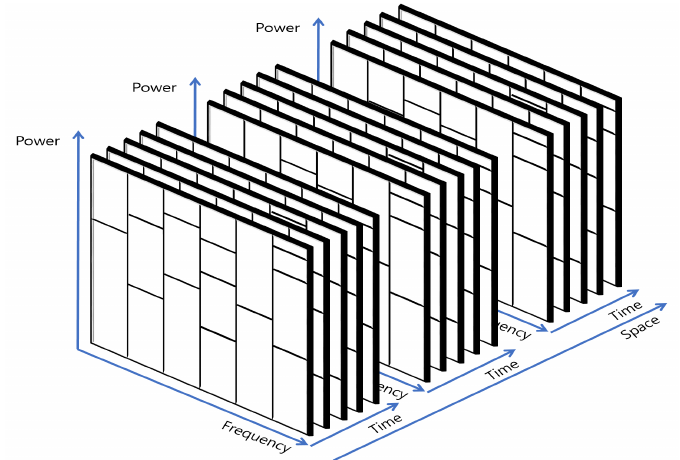
Figure 2. The spectral efficiency using multiple